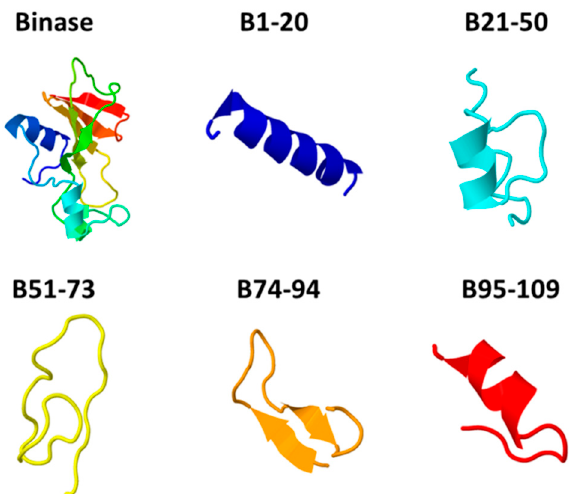
Figure 1. The models of three-dimensional structure of binase-derived peptides in comparison to the binase structure in solution (PDB 1BUJ). The numbers correspond to the numbering of amino acid residues in a binase primary sequence. The color of the models matches the rainbow coloring of the binase spatial structure.